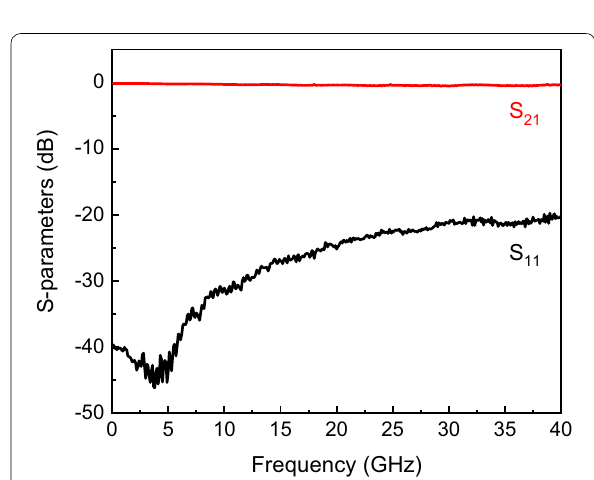
Fig. 9 Insertion loss of Au–Au/CNT‑composite contact RF‑MEMS switch in the ON state